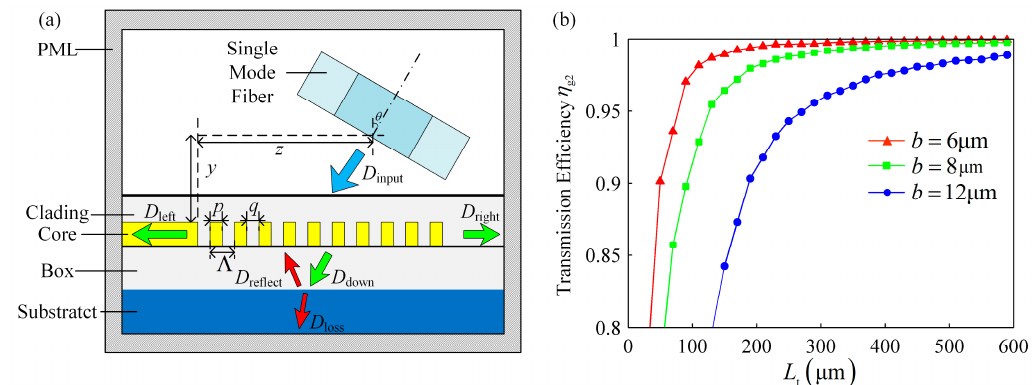
Figure 8. ( a ) Simulation model of the grating part. ( b ) Influence of the width b and length L t on the transmission efficiency η g2 .